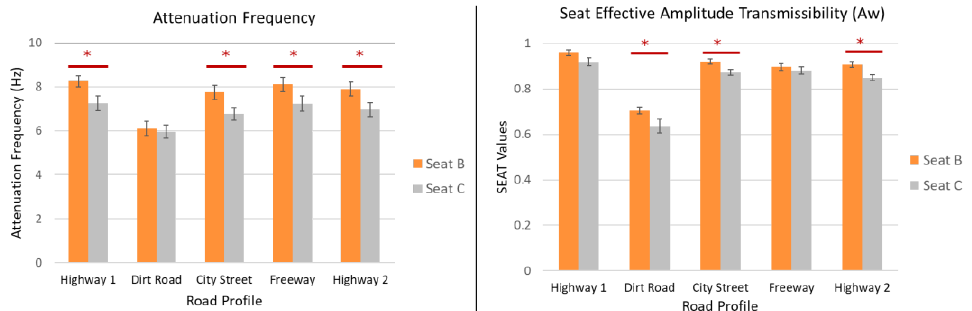
Figure 10. Attenuation frequency ( left ) and Seat Effective Amplitude Transmissibility (SEAT: Aw right ) comparison between Seat B and Seat C ( n = 12). Asterisks indicate statistical significance ( p < 0.05).